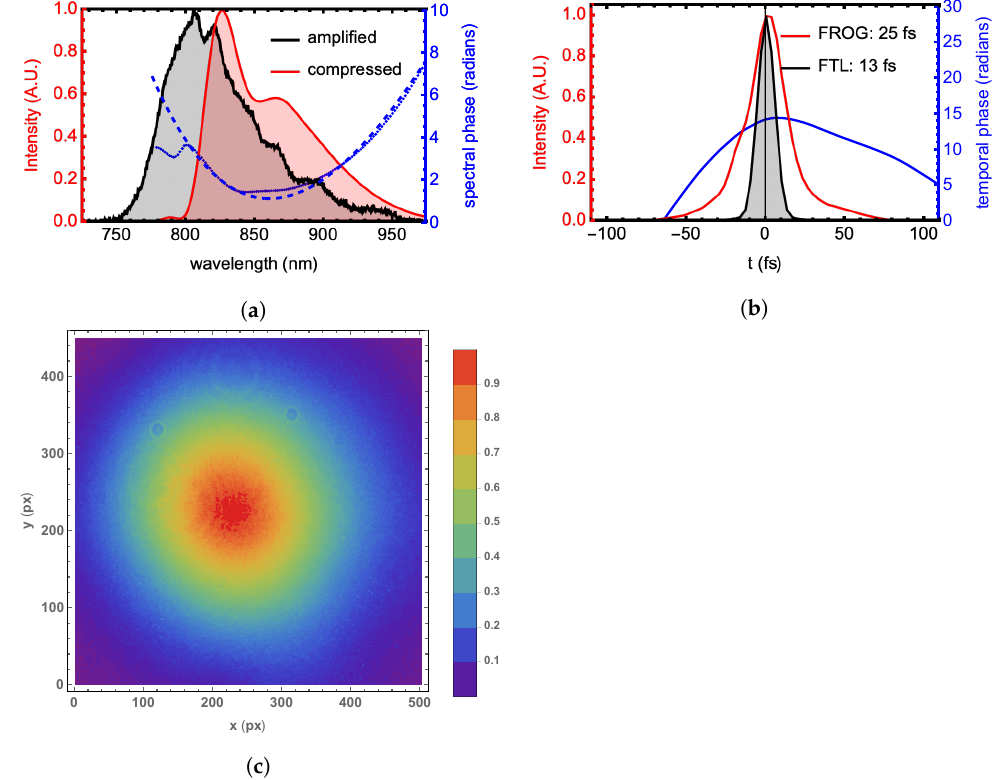
Figure 3. Compressed pulse FROG retrieval: ( a ) retrieved spectral intensity, phase and quadratic phase fit (red, solid blue and dashed blue, respectively), and spectrum measured at compressor input (black); ( b ) retrieved temporal intensity and phase (red and blue, respectively), and corresponding Fourier Transform limit duration (black); ( c ) Compressed beam spatial